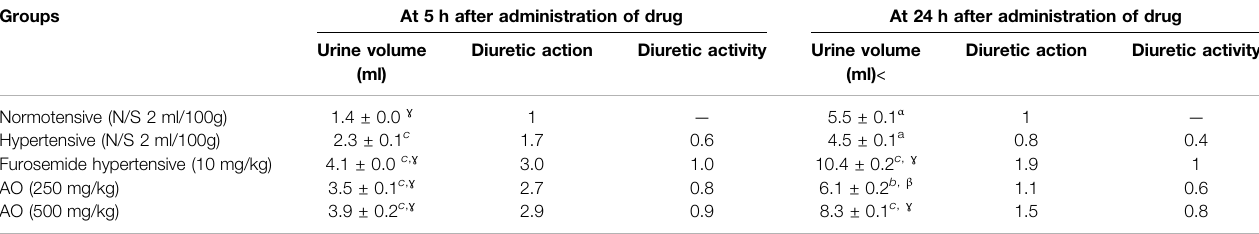
TABLE 7| Effectofadministration of Alpiniaof fi cinarum onurinevolume ofchronic obesogenic diet-fed hypertensiveratsat 5and 24 hintervalsonthelastdayofthemodel. Groups At 5 h after administration of drug At 24 h after administration of drug Urine volume Diuretic action Diuretic activity Urine volume Diuretic action Diuretic activity (ml) (ml) < Normotensive (N/S 2 ml/100g) 1.4 ± 0.0 ɣ Hypertensive (N/S 2 ml/100g)